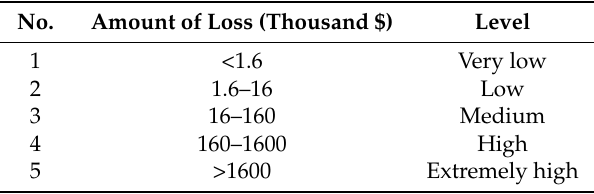
Table 2. Ranking criteria of consequences.